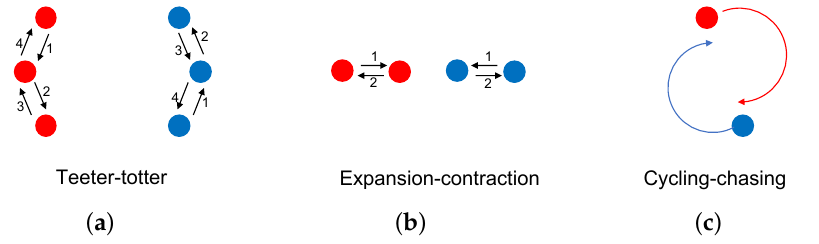
Figure 6. Stabilized patterns for different interactions between two quasiparticles. The ( a ) panel shows the quasiparticles get locked in a teeter-totter type of oscillation; as the first particle (red) moves from position 1 to 2 as in the figure, the second particles (blue) moves into the positions 1 and 2; the dynamical evolution can be watched in the movie at https://youtu.be/L1KPckojco4. The ( b ) panel shows a movement in which the particles come closer in one frame and get separated in the next, pattern that keeps repeating. The ( c ) panel shows the particles chasing each other in